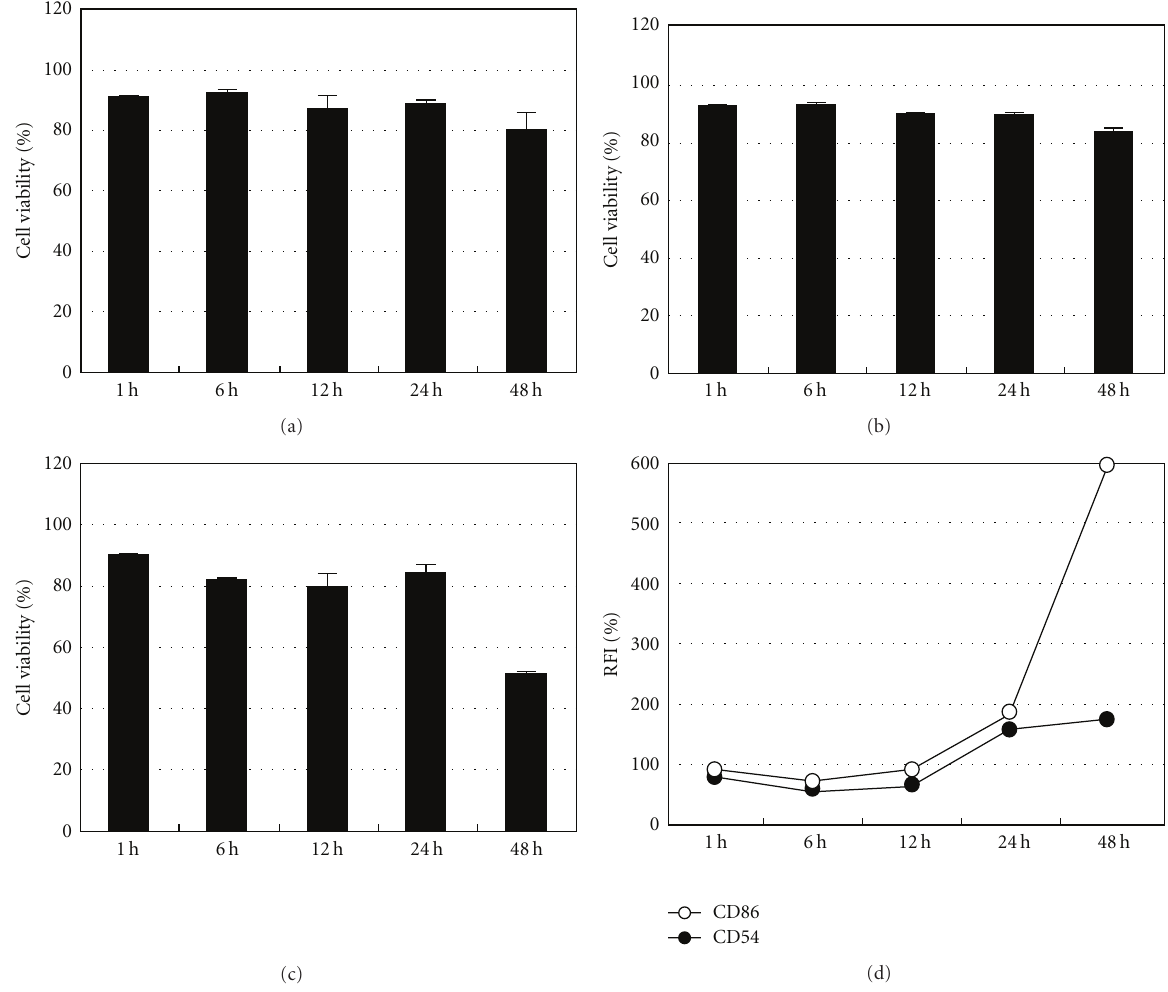
Figure 1: Comparison between cell viabilities of positive control, solvent, and medium only. All cell viabilities were measured by time progression. (a) Cell viability in RPMI medium 1640, (b) cell viability in DMSO (2 μ L/mL), (c) cell viability in DNCB (5.2 μ g/mL), and (d) CD54 and CD86 expression levels over time with DNCB (5.2 μ